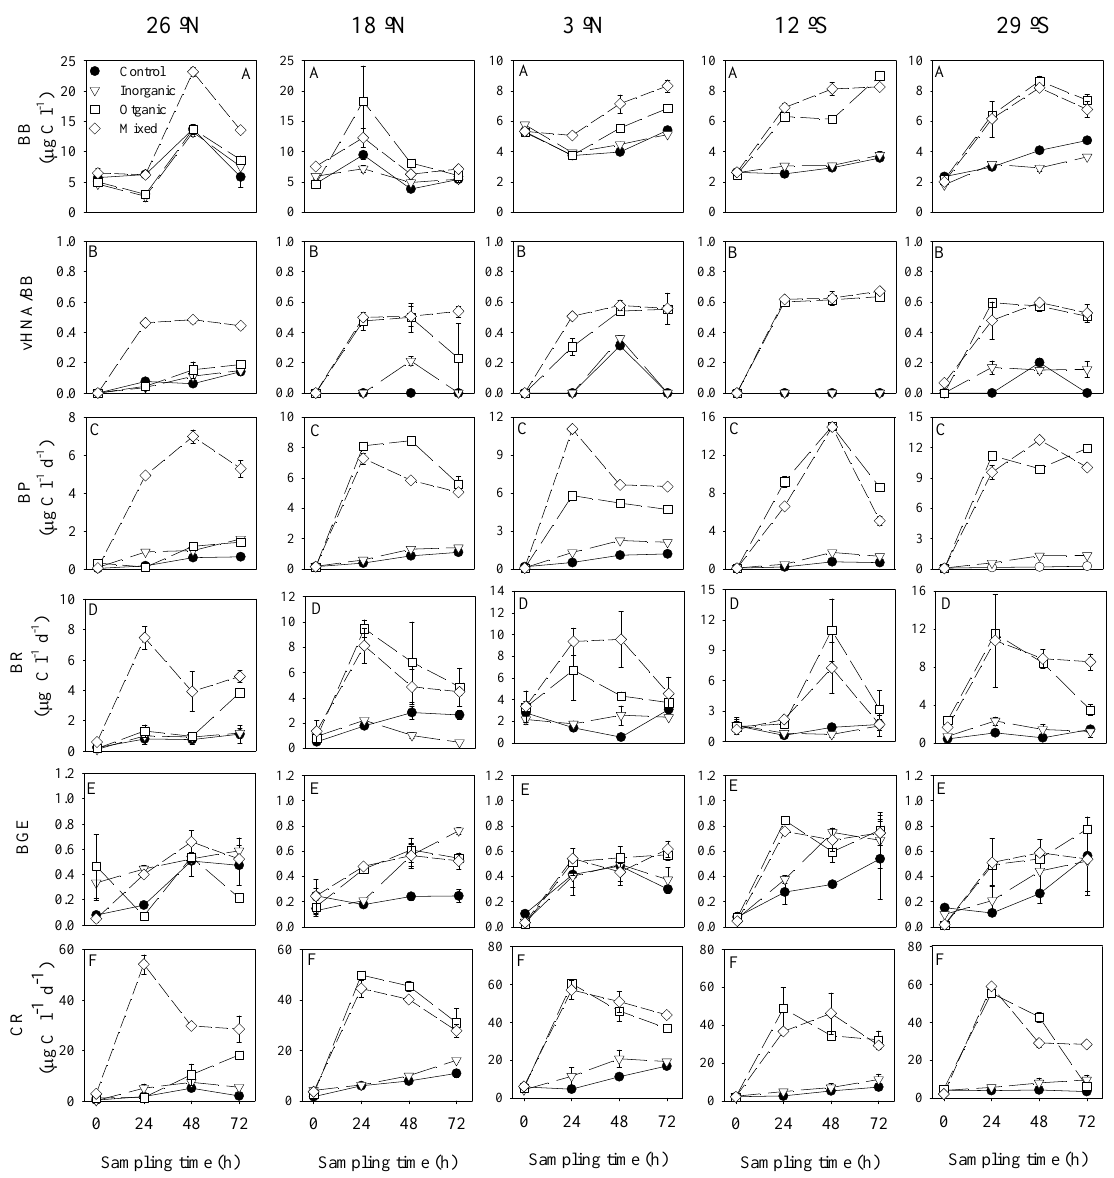
Fig. 5. Time course of the mean (A) , BB, bacterial biomass (µgCl − 1 ) ; (B) , vHNA:BB, vHNA: Bacterial Biomass ratio; (C) , BP, bacterial production (µgCl − 1 d − 1 ) ; (D) , BR, bacterial respiration estimated from ETS activity in the fraction < 0.8µm (µgCl − 1 d − 1 ) ; (E) , BGE, bacterial growth efficiency; (F) CR, community respiration estimated from total ETS activity (µgCl − 1 d − 1 ) , in the 5 experiments. Control, no addition; Inorganic, inorganic addition; Organic, organic addition; Mixed, mixed addition. Note that different scales were used. Error bars represent the standard error from two replicates; where error bars are not visible, they are smaller than the size of the